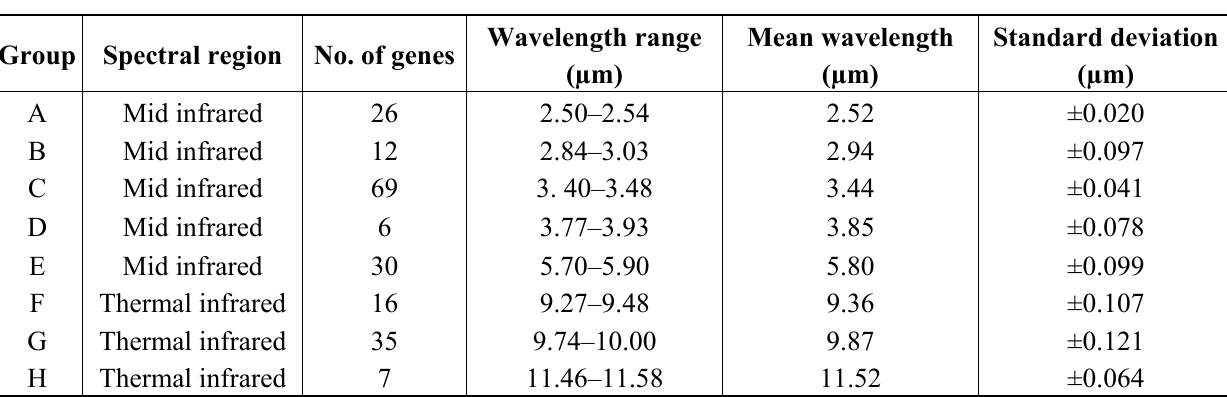
Table 3. Summary of the clustering of selected genes (wavebands), the number of genes, spectral range, means wavelength location and standard